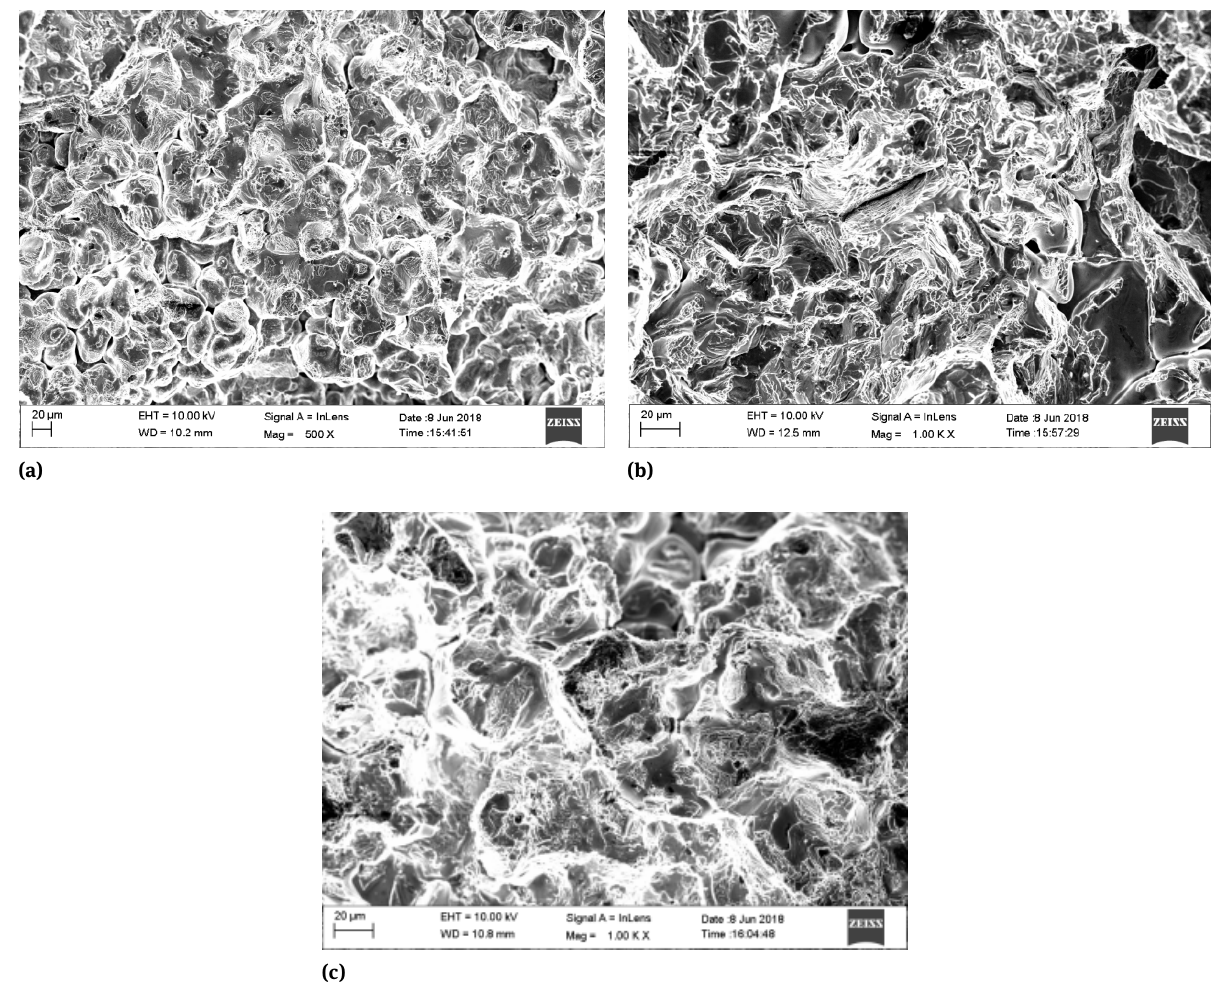
Figure 9: FESEM fractographs of TiB 2 /AA7010 composites (a) 5% TiB 2 , (b) 7.5% TiB 2 and (c) 10% TiB 2